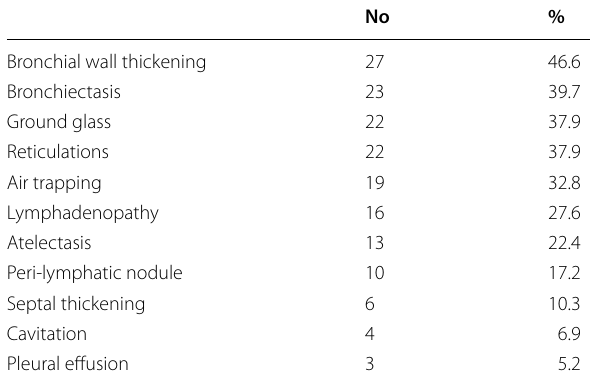
Table 1 Number and percentages of the associated HRCT